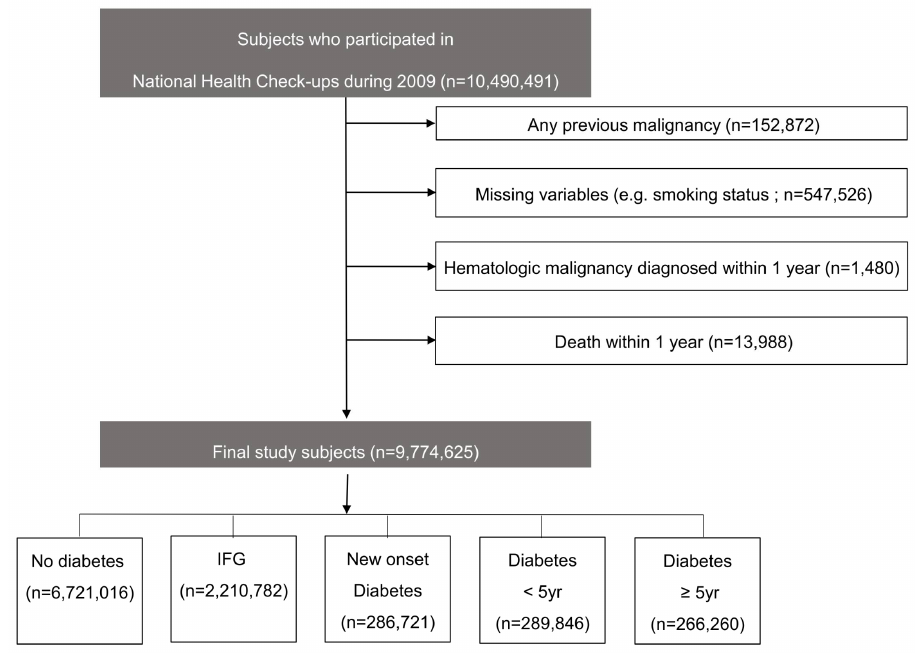
Figure 1. Flowchart of the study protocol and participants. IFG, impaired fasting